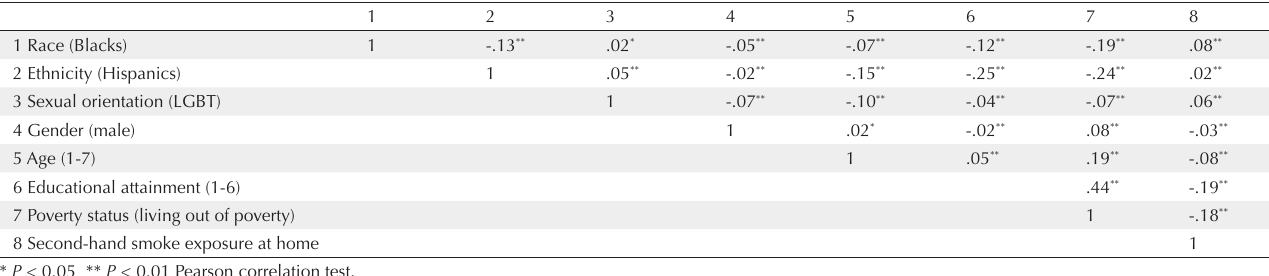
Table 2. Bivariate